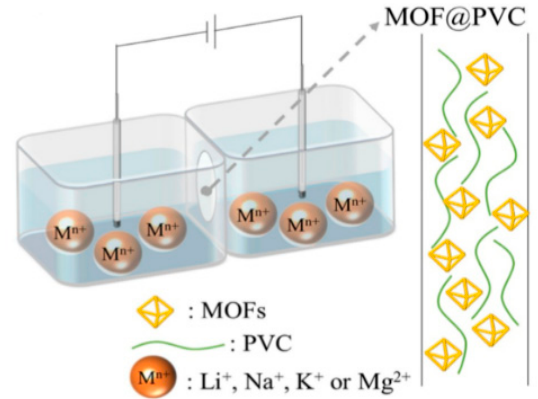
Figure 14. Schematic diagram of the test for ion conductivity [106].